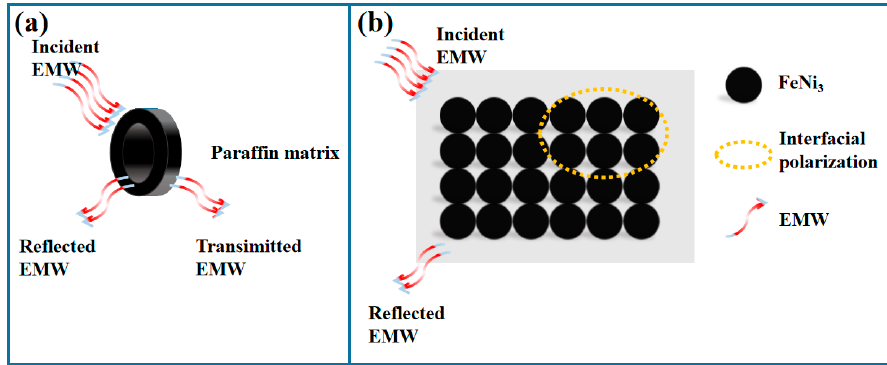
Figure 13. The mechanism of the electromagnetic wave absorption performance of ( a ) the testing ample ring, ( b ) the FeNi 3 alloy sample.